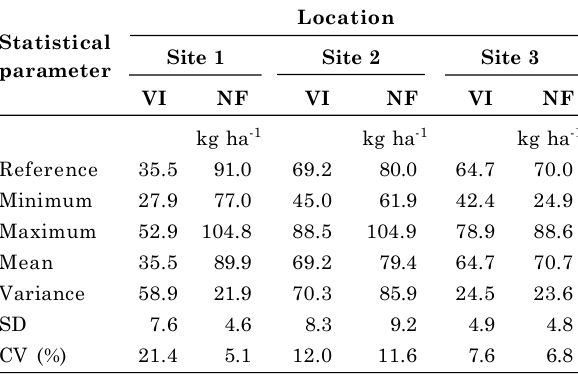
Table 2. Statistical parameters of variable-rate fertilization based on the optical sensor at the phenological stage V8 of corn